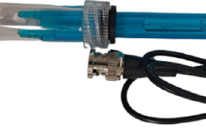
Figure 11. pH sensor.